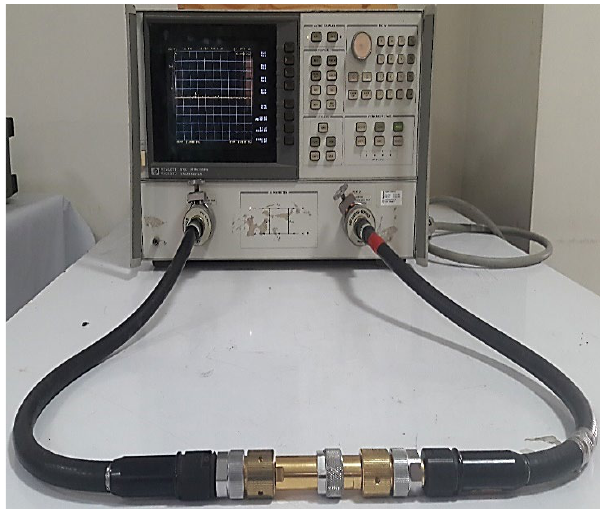
Fig. 13. Ports are connected via a coaxial cable for matching.